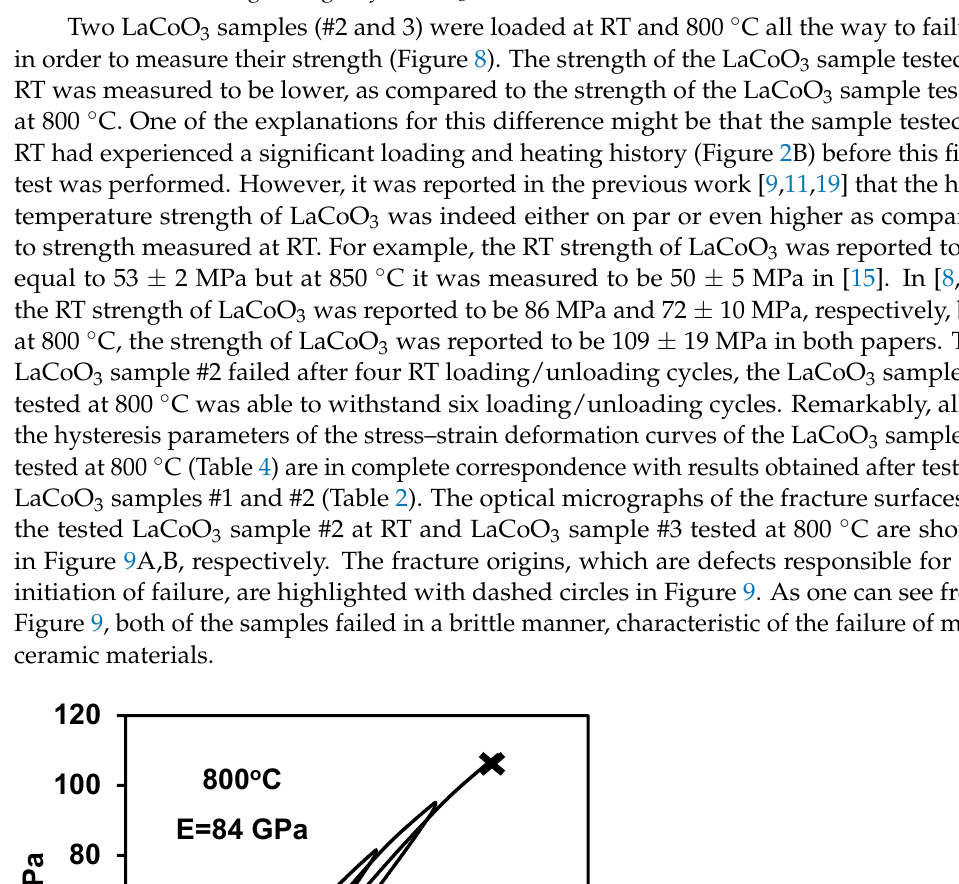
Table 3. The creep strain shift Δε of two LaCoO 3 samples calculated at loading/unloading cycle 3 and loading cycle 4 at different temperatures.